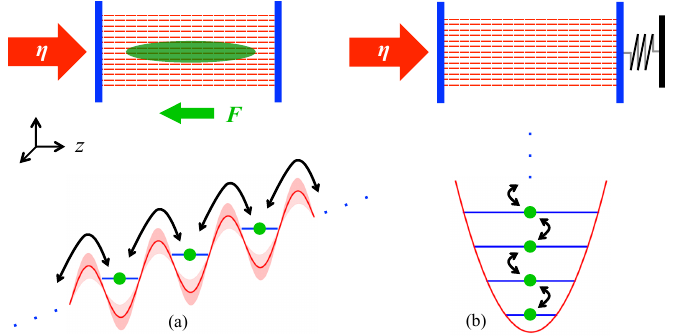
Figure 1. ( a ) An optical lattice is created by pumping a Fabry–Perot cavity. The bias force F tilts the lattice potential and causes a trapped Bose–Einstein condensate (green) to undergo Bloch oscillations. Atomic backaction leads to a time-modulation of the lattice amplitude, which in turn induces coherent directed transport of the condensate, provided the total detuning from resonance is not zero. The transport corresponds to atoms climbing or descending the ladder of Wannier–Stark states, where each state is separated by the energy ¯ h ω B . ( b ) The archetype of cavity optomechanics is a cavity with one end mirror suspended on a spring. The motional states of the mirror correspond to the excitations of a harmonic oscillator. Cavity amplification or cooling of the mirror moves it up or down the ladder of oscillator states. Bloch oscillation dynamics in a cavity can be mapped onto standard cavity optomechanics, but with the harmonic oscillator ladder replaced by the Wannier–Stark